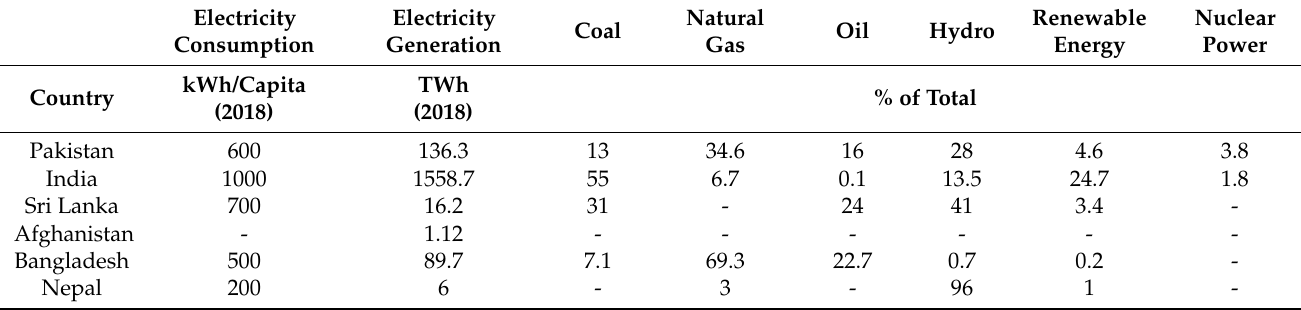
Table 1. Electricity generation of South Asian countries.